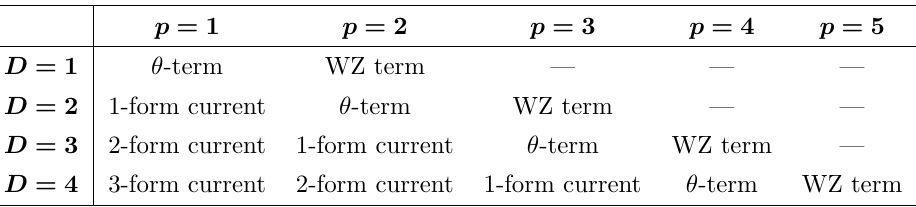
Table 1 . Physical interpretation of p -form cohomology generators depending on the spacetime dimension D . Only generators relevant in D ≤ 4 dimensions are included. In general, a cohomology generator of degree p on the coset space G/H pulled back to D > p spacetime dimensions gives a topologically conserved ( D − p ) -form current, and hence a ( D − p − 1) -form